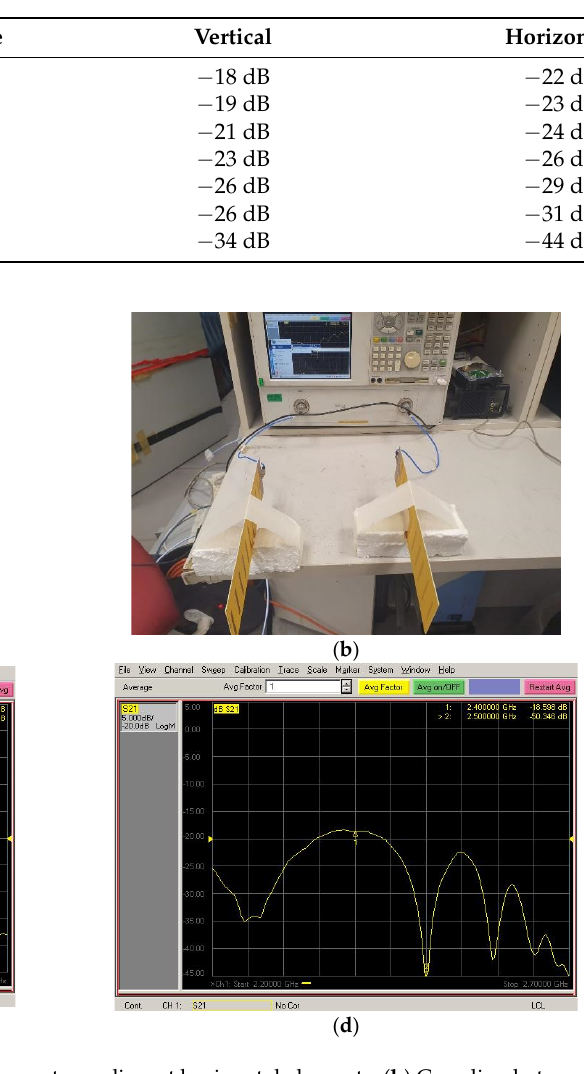
Figure 7. ( a ) Coupling between two adjacent horizontal elements; ( b ) Coupling between two adjacent vertical elements; ( c ) Coupling between two adjacent horizontal elements in 2.4 GHz, d x = λ ; ( d ) Coupling between two adjacent vertical elements in 2.4 GHz, d z = 0.7 λ Table 5. Yagi–Uda coupling measurements between adjacent elements (S12) in the vertical and hor- izontal positions.